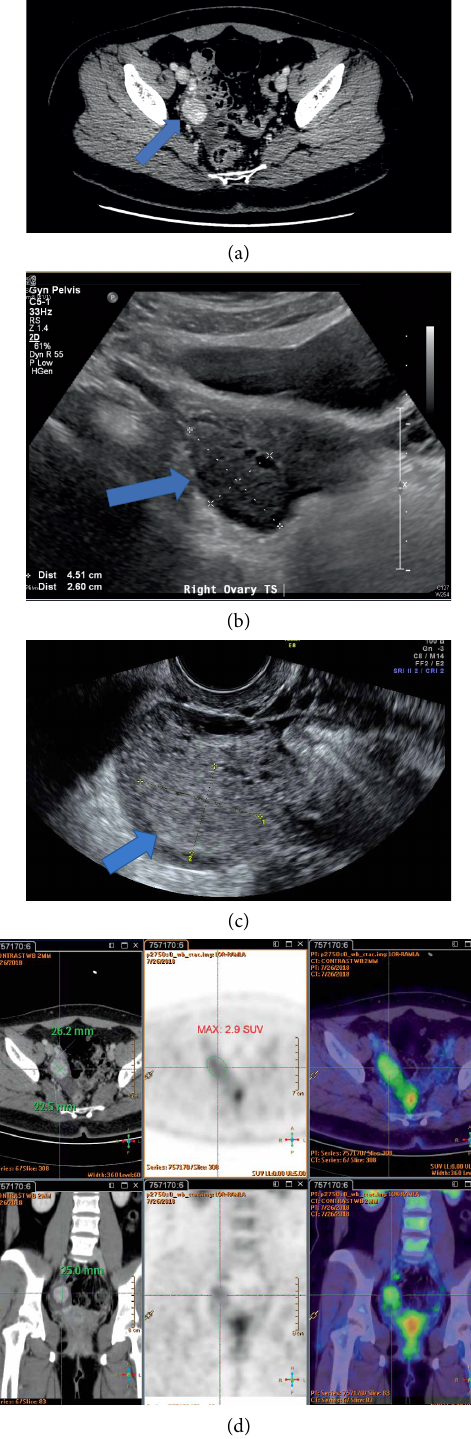
Figure 1: (a) Contrast CT scan of the abdomen and pelvis showed an enlarged 2.6 × 2.3 × 2.5 cm right ovary (blue arrow). (b) Transabdominal ultrasound showed an enlarged 4.5 × 2.6 × 4.5 cm right ovary five months after CT scan (blue arrow) (c) Transvaginal ultrasound showed a 2.6 × 2.4 × 2.2 cm hyperechoic solid tumor inside the right ovary (blue arrow) (d) FDG PET–CT scan with contrast showed a 2.6 × 2.3 × 2.5 cm mildly FDG-avid mass (SUV in the right ovary (tumor dimensions